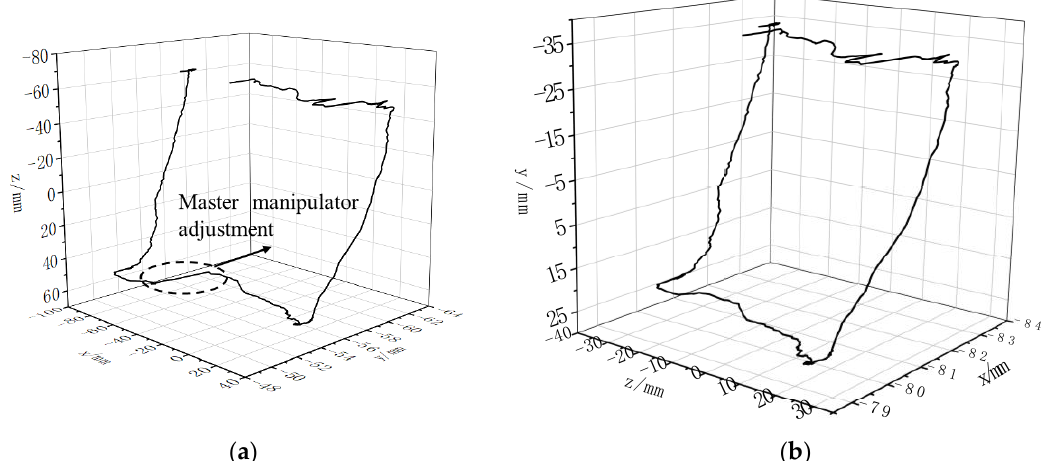
Figure 12. Master – slave trajectory. ( a ) Master manipulator trajectory. ( b ) End trajectory of the slave manipulator.